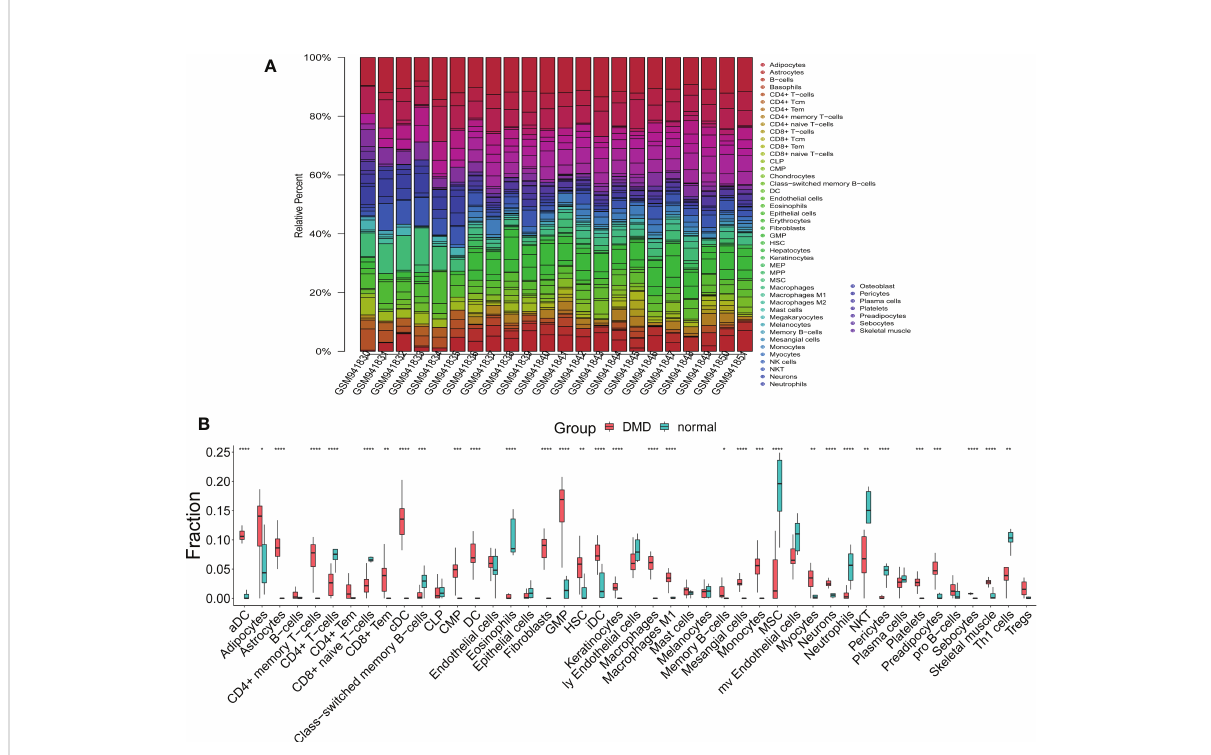
FIGURE 7 The results of immune and stromal cell in fi ltration analysis. (A) The distribution of in fi ltrated immune and stromal cells in DMD and normal samples. (B) A box plot of in fi ltrated immune and stromal cells in the DMD and normal groups. *p < 0.05, **p < 0.01, ***p < 0.001, ****p < 0.0001.